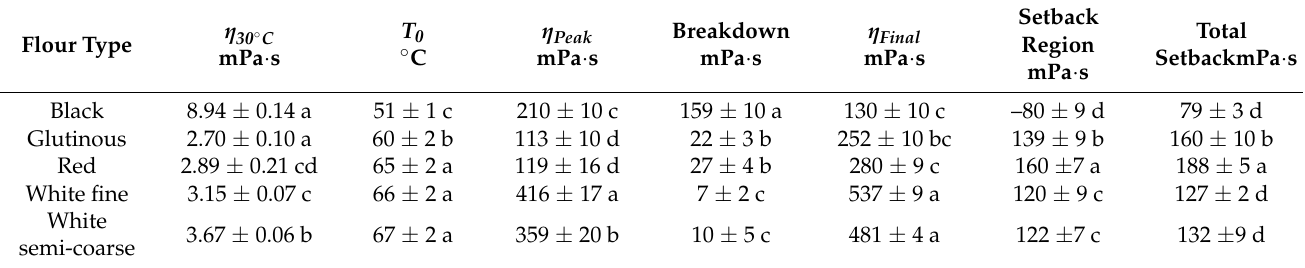
Table 3. Pasting properties of flours ( η 30 ◦ C viscosity at 30 ◦ C, T 0 temperature when viscosity started to rise, η Peak peak viscosity, breakdown, η Final final viscosity, setback region, total setback) 3